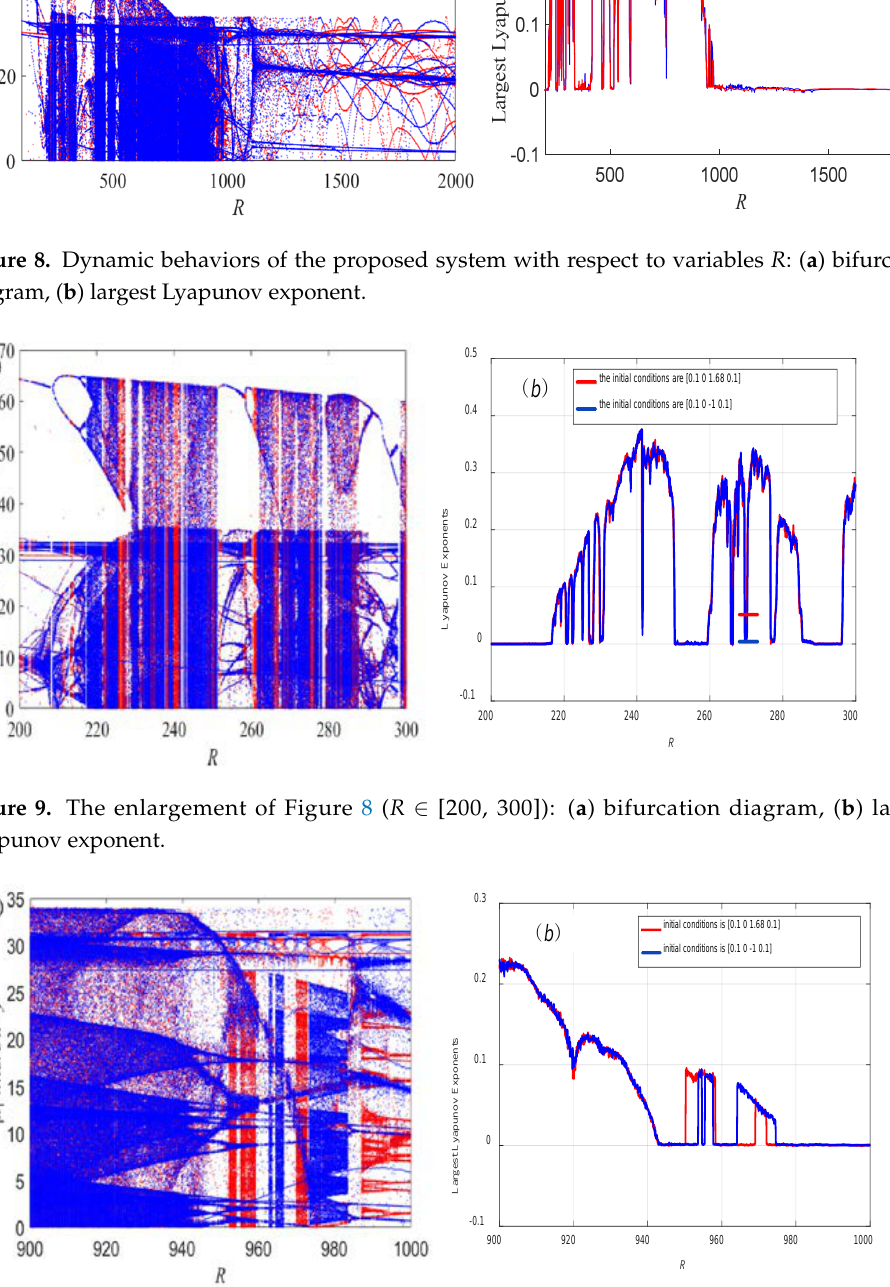
[900, 1000]): ( a ) bifurcation diagram, ( b ) largest Lya- ∈